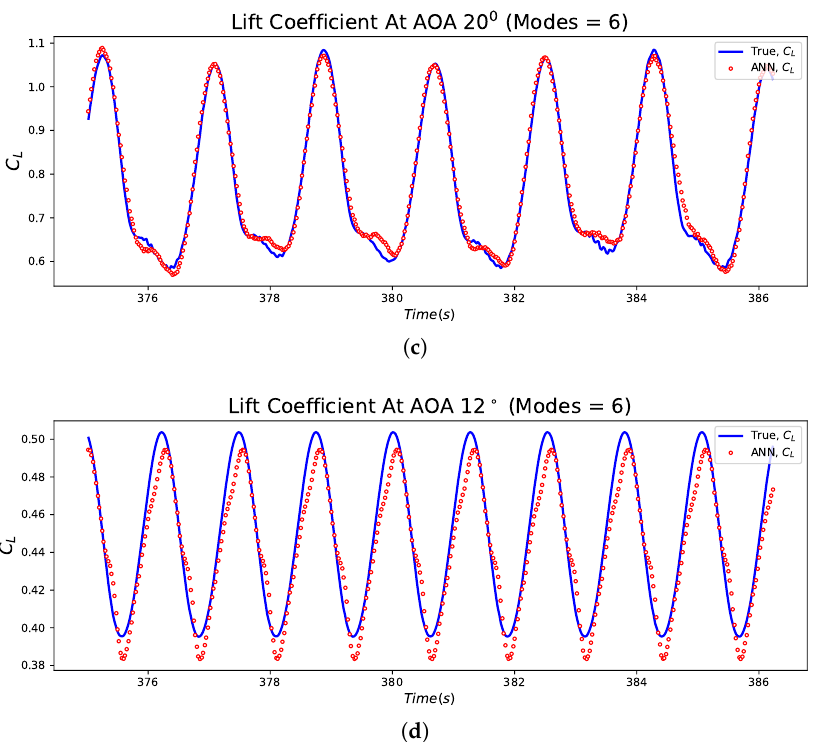
Figure 15. ( a ) Lift coefficient prediction at AOA 10 ◦ using six modes. ( b ) Lift coefficient prediction at AOA 15 ◦ using six modes. ( c ) Lift coefficient prediction at AOA 20 ◦ using six modes. ( d ) Lift coefficient prediction at AOA 12 ◦ (out of sample data) using six